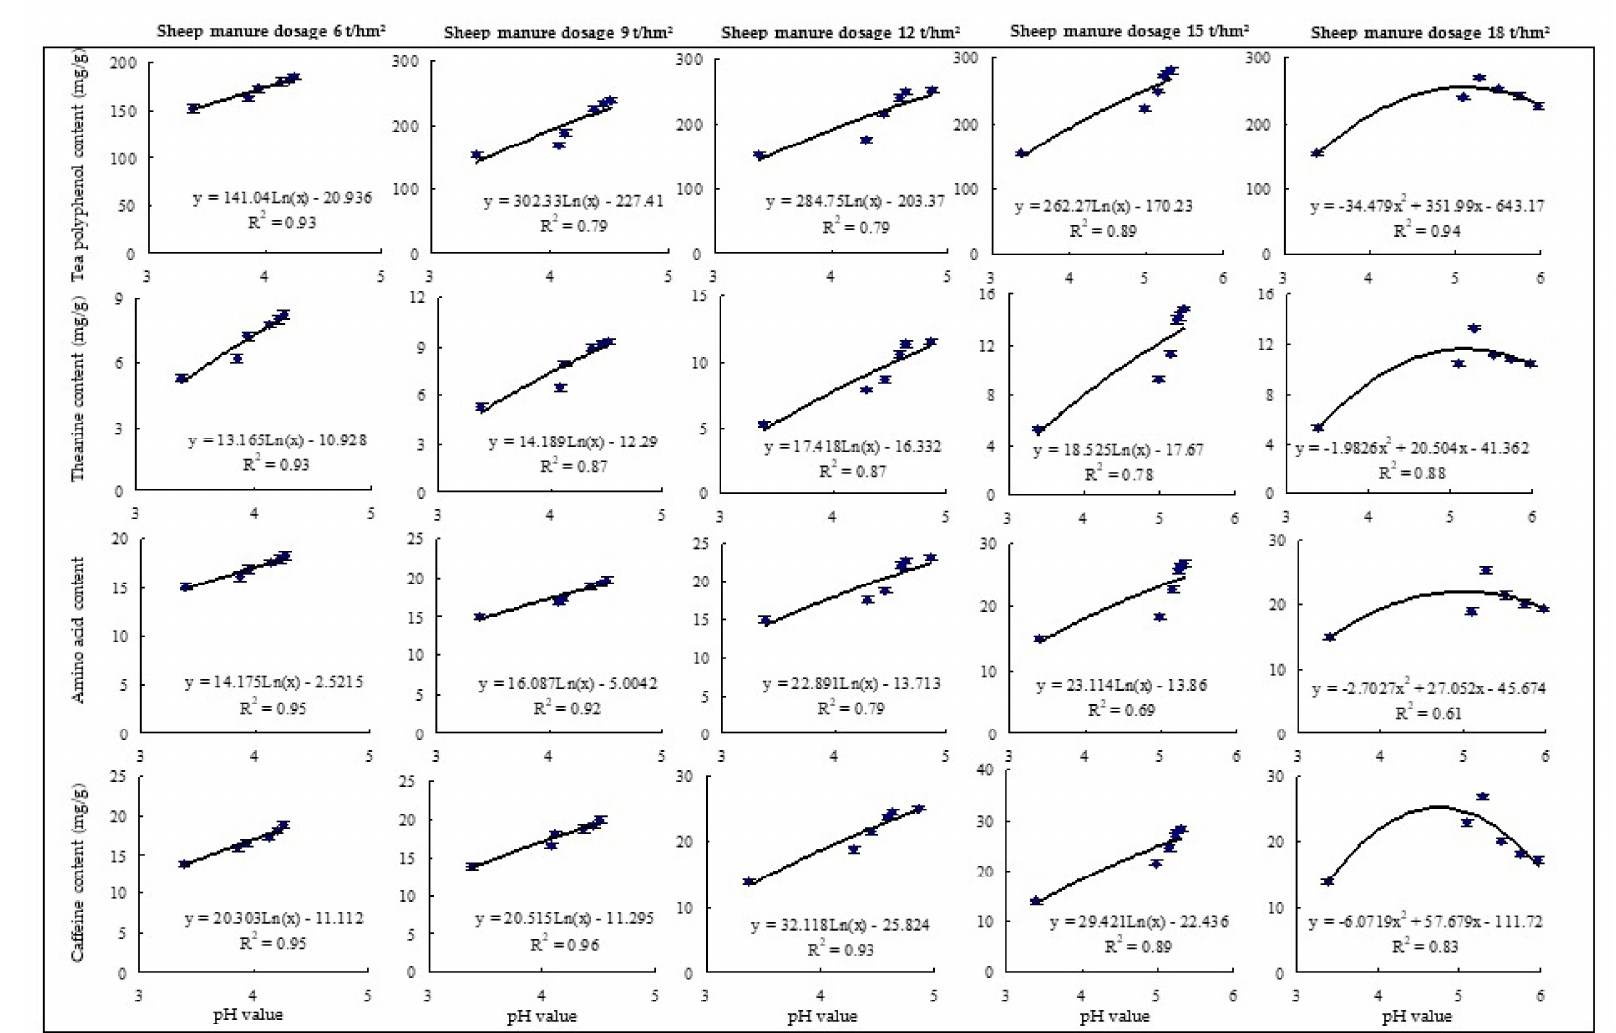
Figure 3. Effects of pH value on tea quality indexes during continuous use of sheep manure fertilizer with different